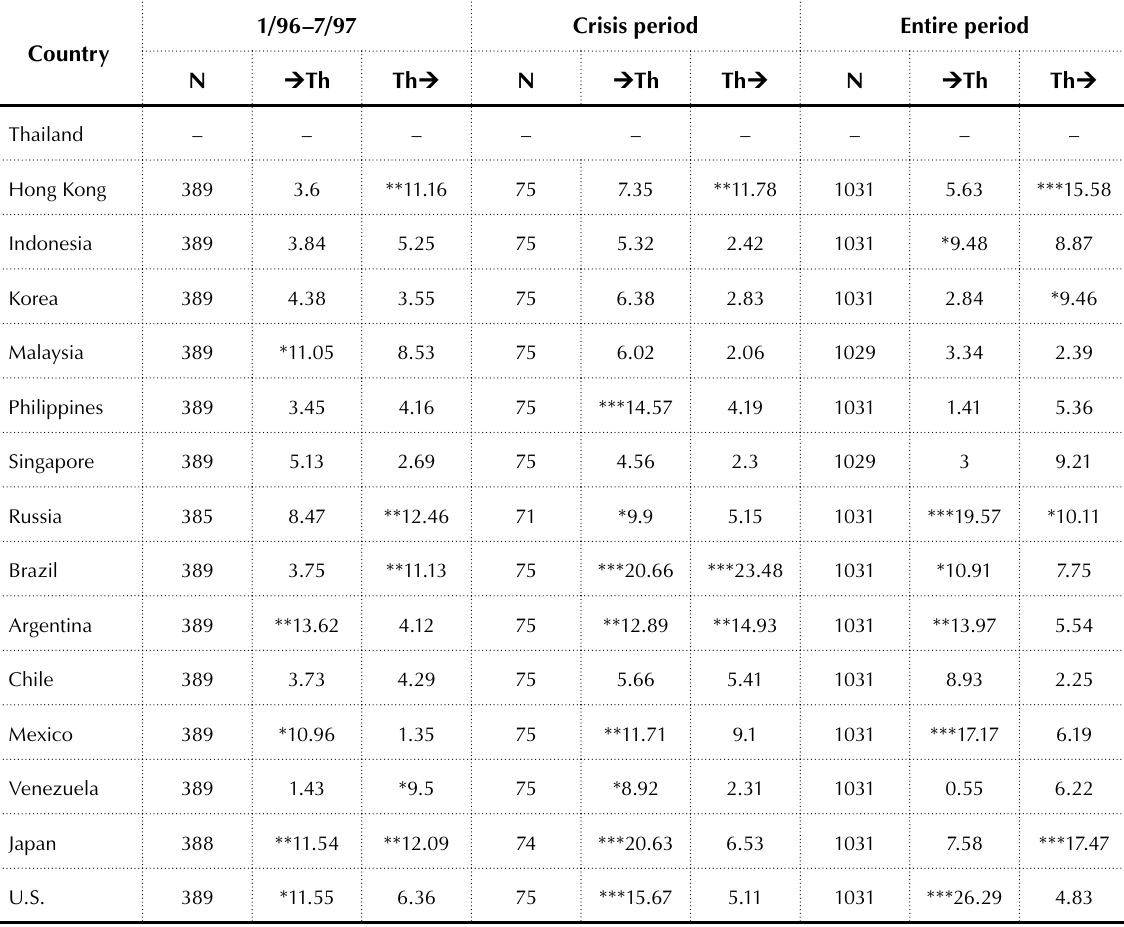
Table 2. Liquidity contagion after the Thai crisis Country